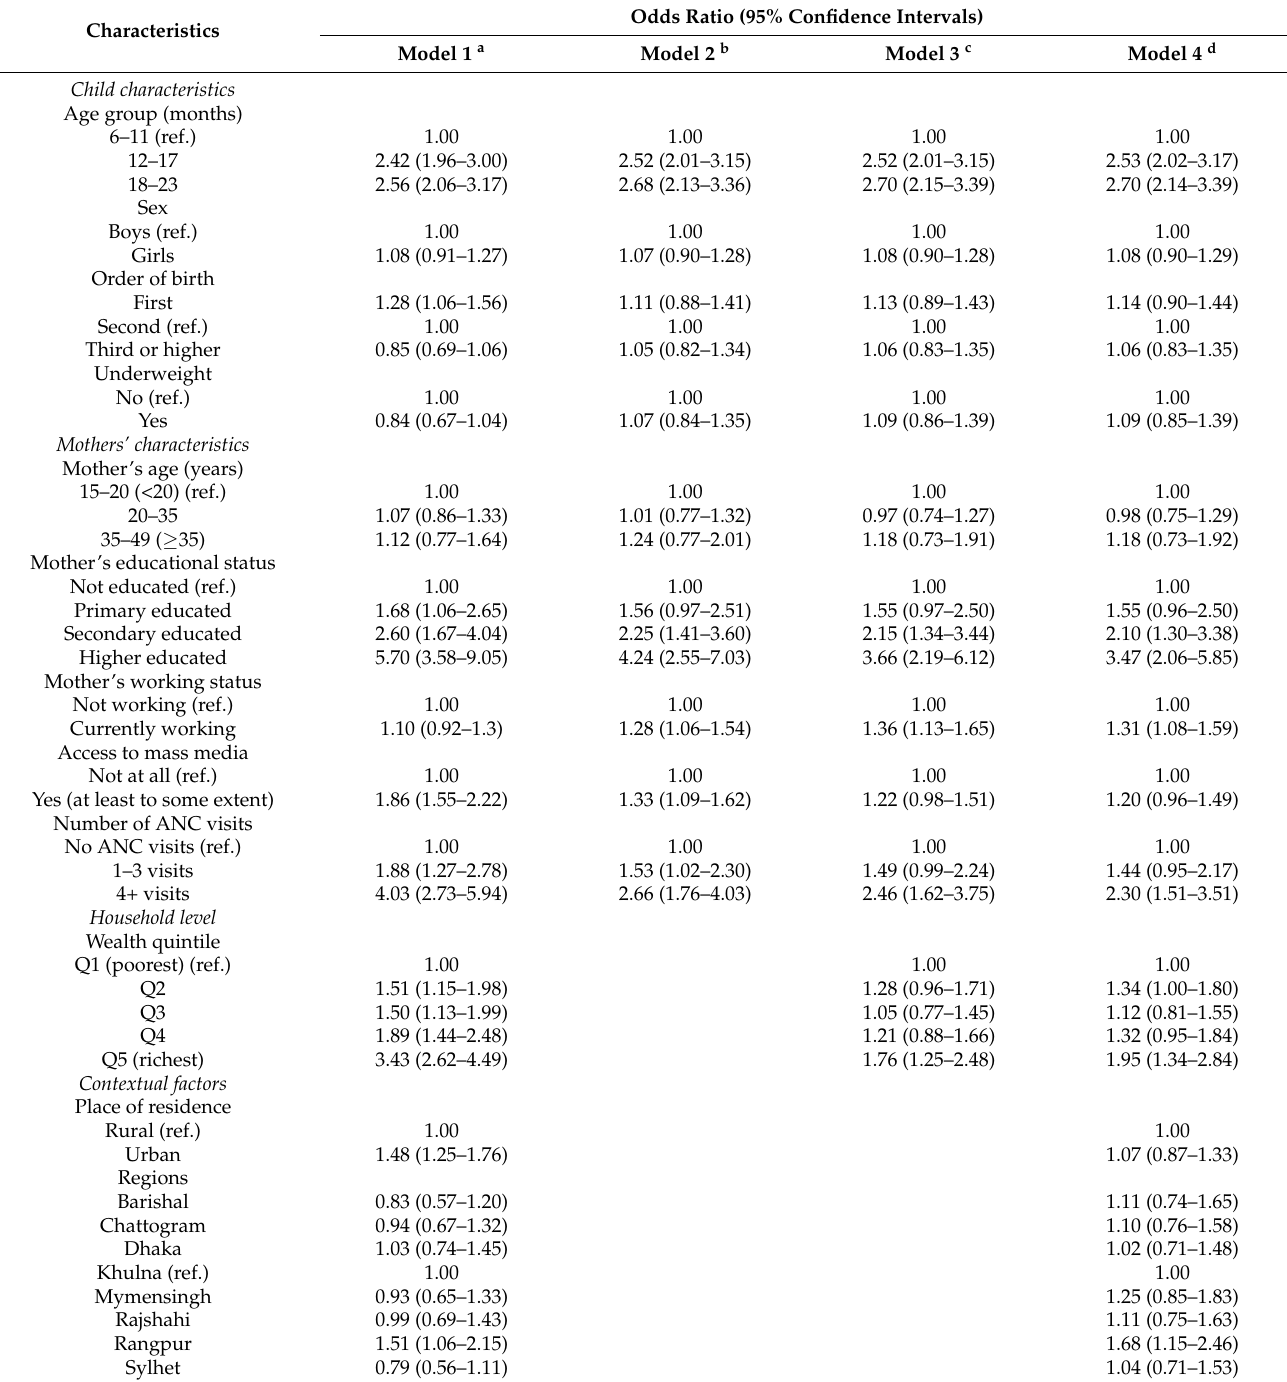
Note: Based on the results of likelihood ratio tests, estimates of fixed effect logistic regression models were preferred over mixed-effect models. The results of mixed-effect logistic regression models are presented in Table S7. a Model 1, unadjusted model. b Model 2 included only children’s characteristics and their